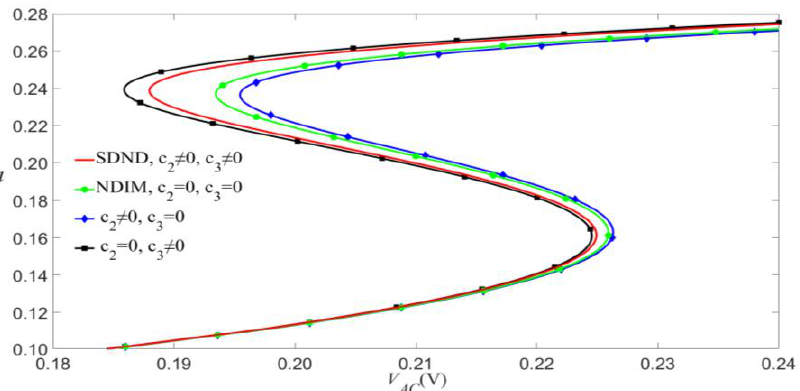
Figure 13. Comparison in amplitude of the response as a function of the load’s amplitude by considering different nonlinear damping terms.